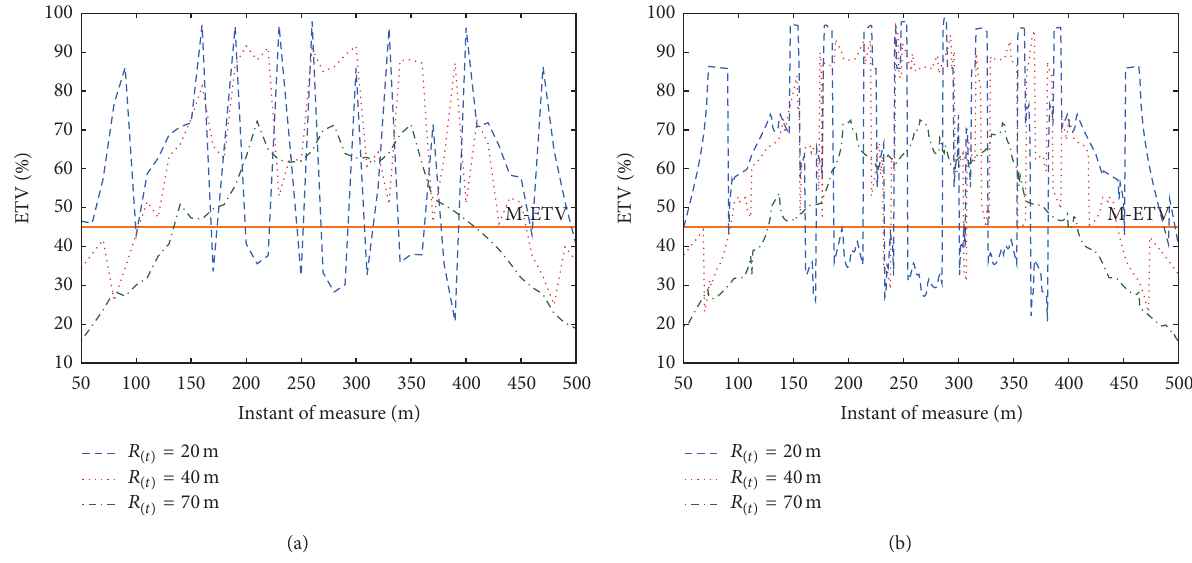
Figure 15: ETV after deployment of four more visual sensors. (a) Targets move 10 m for each measure. (b) Targets move 1m for each measure.